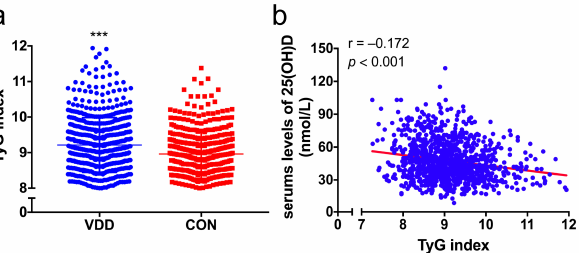
Figure 2. Comparison of the TyG index levels between the two groups ( a ) and the correlation be-